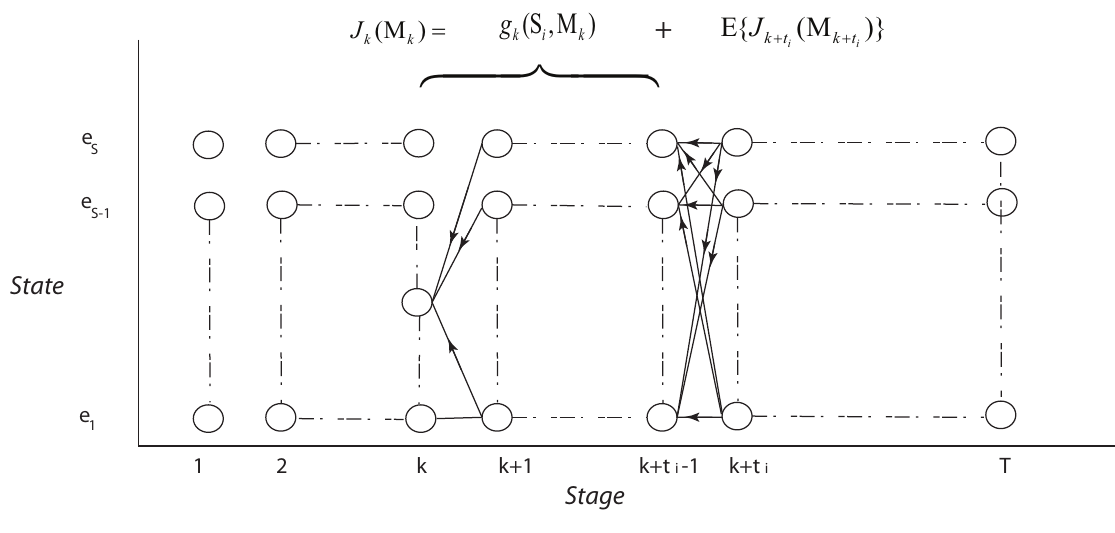
Figure 4. state-stage diagram of SDP with S number of states and T number of stages